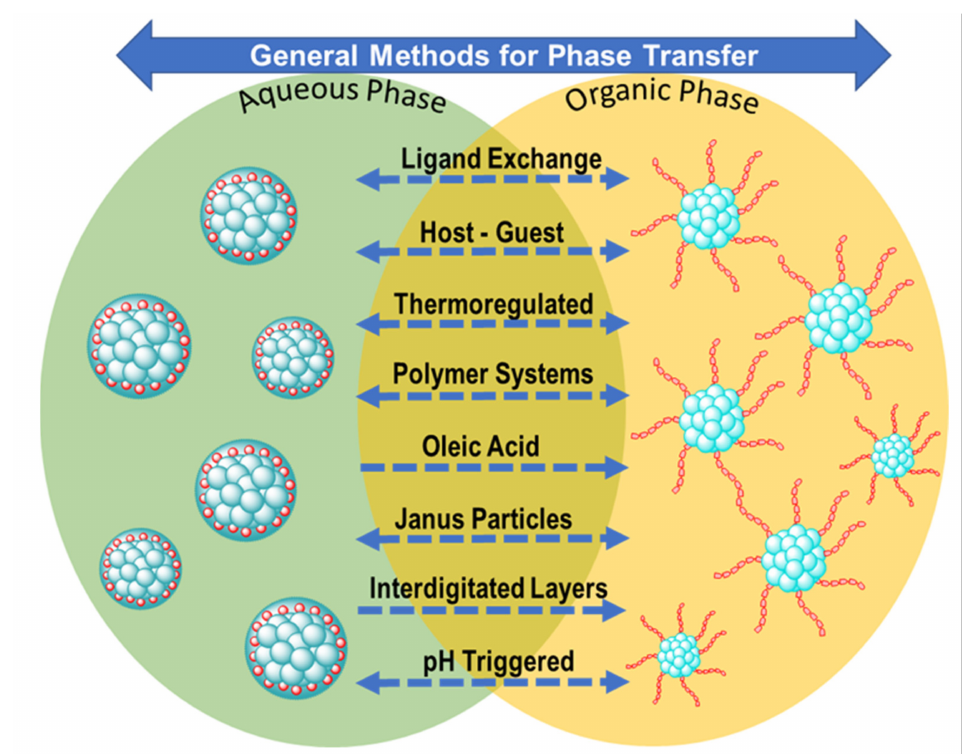
Figure 1. Schematic representation of the general methods for the phase transfer of